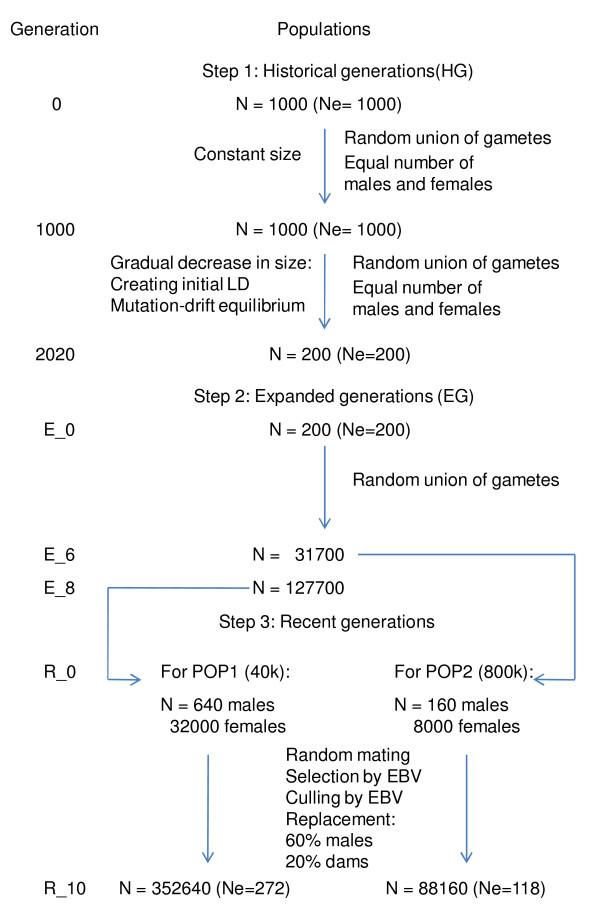
Schematic representation of the simulation steps.